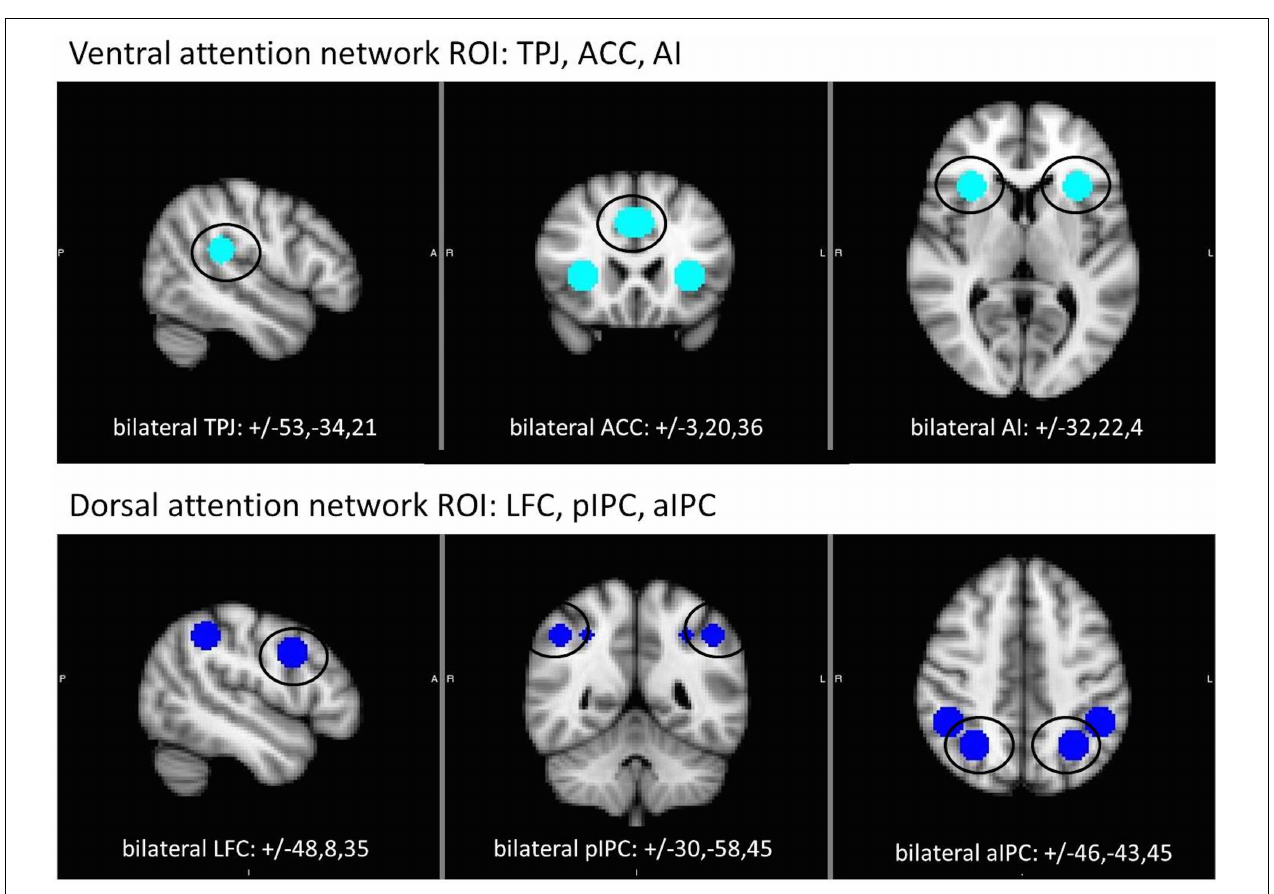
FIGURE 2 | Location of regions of interest (ROI) within the ventral (top) and dorsal (bottom) attention networks. Each ROI (9 mm sphere) centered on coordinates shown in Montreal Neurological Institute (MNI) standard space. ACC, anterior cingulate cortex; AI, anterior insula; aIPC anterior intraparietal cortex; LFC, lateral frontal cortex; pIPC, posterior intraparietal cortex; TPJ, temporo-parietal